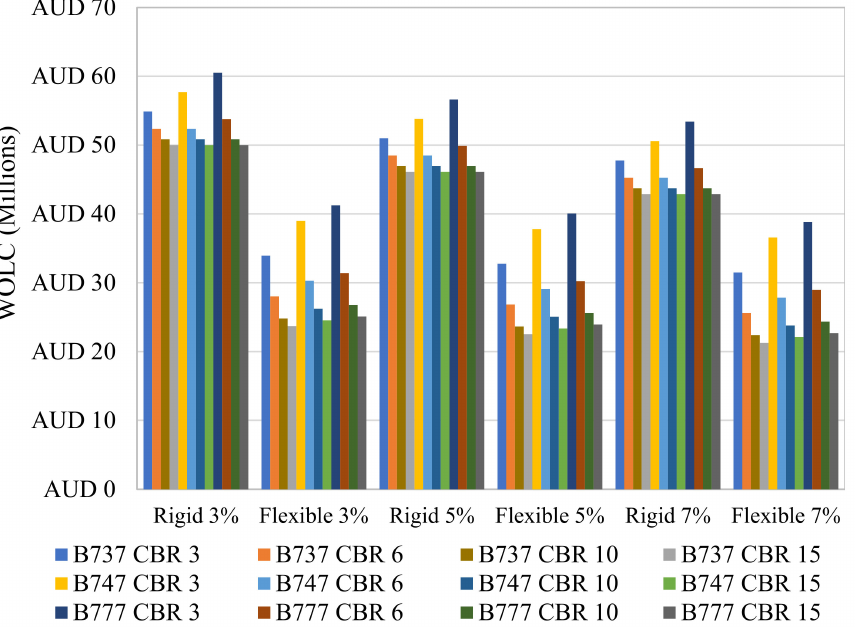
Figure 5. Forty-year WOLC for different discount